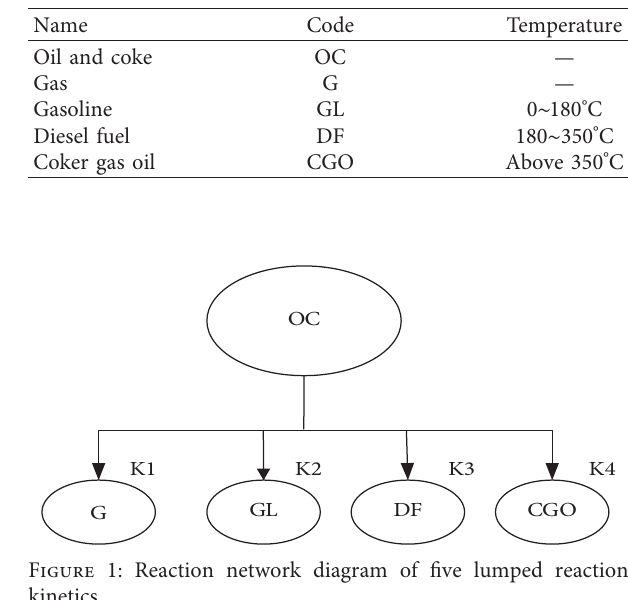
Table 1: Delayed coking reaction heavy oil lumped code.